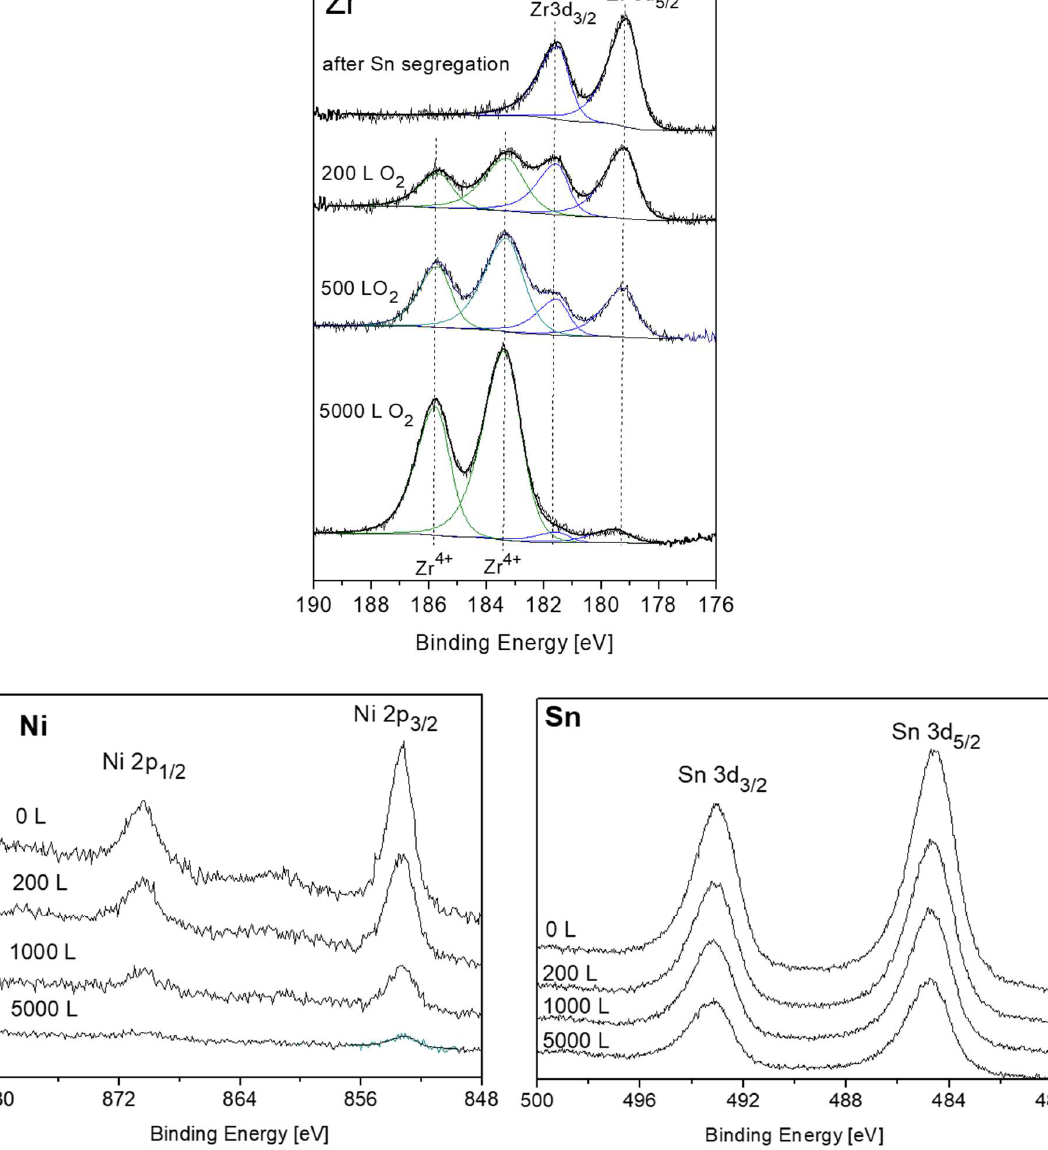
Figure 10. Representative XPS spectra of Zr, Ni and Sn after exposing to oxygen at 1000 K.